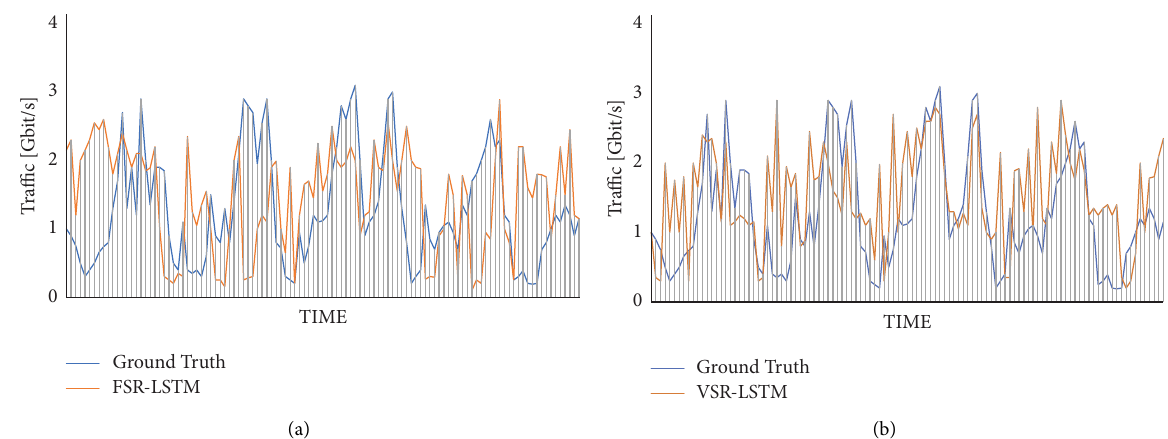
Figure 4: Trafc prediction carve obtained with diferent models. (a) FSR-LSTM. (b) VSR-LSTM.